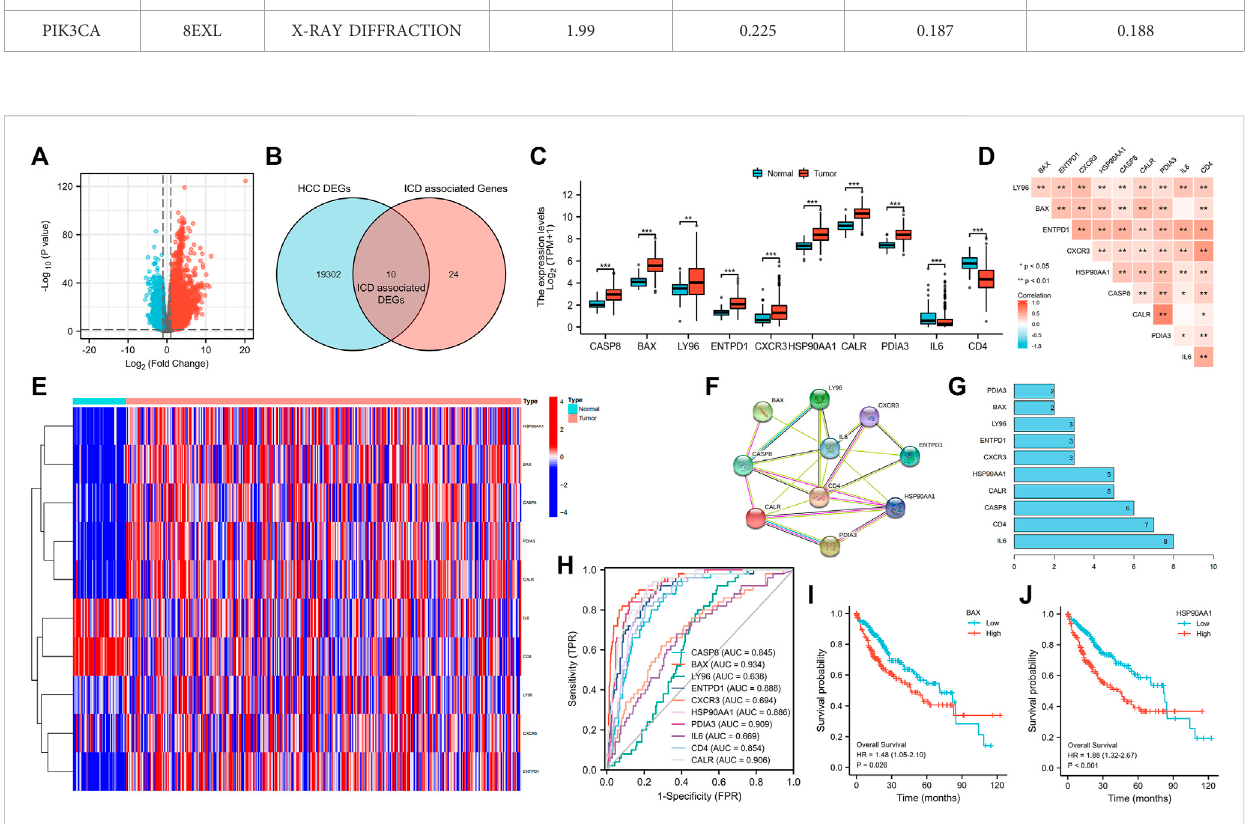
FIGURE 1 Volcano plot of HCC DEGs (A) , and Venn diagram (B) , bar chart (C) , correlation heatmap (D) , genes expression heatmap (E) , the protein-protein interaction networks (F) , genes sorted by quantity of nodes (G) and ROC curve (H) of ICD associated DEGs, and survival curves of BAX (I) and HSP90AA1 (J) . (HCC: Hepatocellular carcinoma, DEGs: Differentially expressed genes, ICD: Immunogenic cell death, ROC curve: The receiver operating characteristic curve; * p < 0.05, ** p < 0.01, *** p <